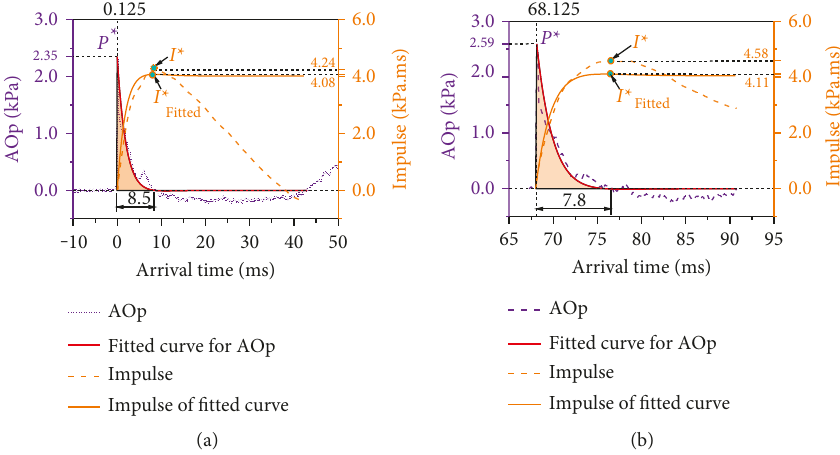
Figure 11: Friedlander equation fitting of the AOp curve: (a) Point A and (b) Point B.